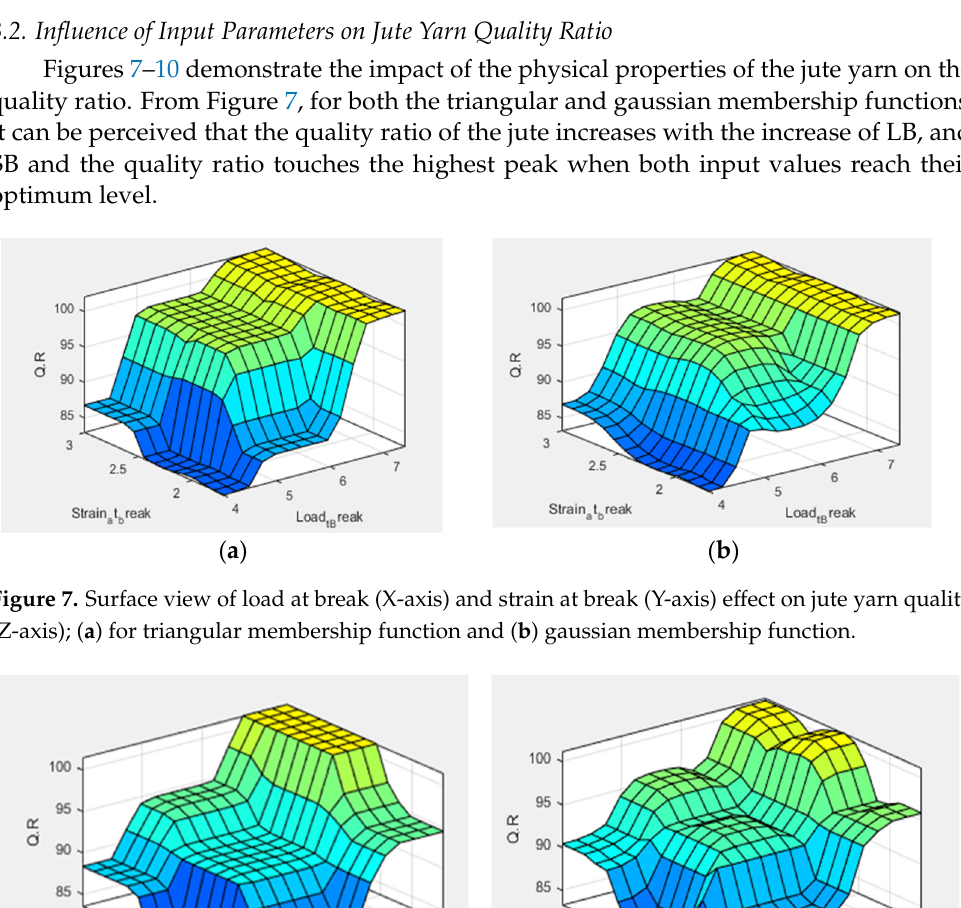
Figure 8. Surface view of load at break (X-axis) and tenacity at break (Y-axis) effect of jute yarn quality (Z-axis); ( a ) for triangular membership function and ( b ) gaussian membership function.